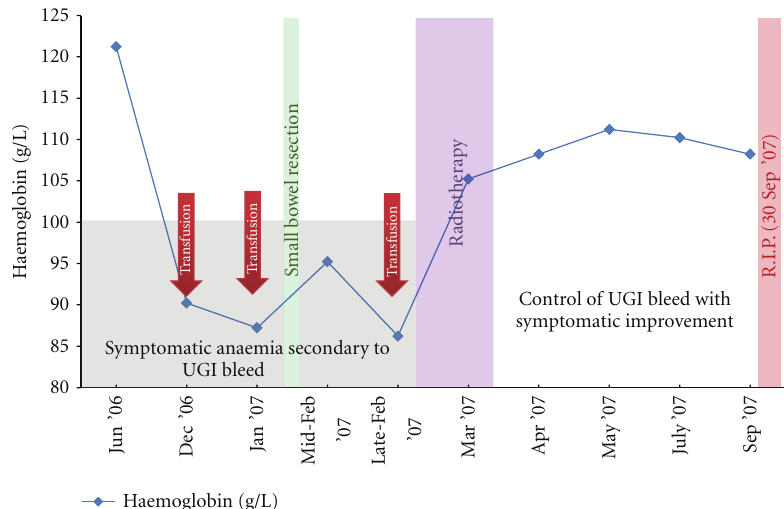
Figure 5: Pre- and postradiotherapy haemoglobin levels of the patient in Case 2. The patient became symptomatic from an occult bleeding caused by a duodenal metastasis of cutaneous melanoma and required continuous transfusion. Palliative radiotherapy of 20 Gy/5 fractions was delivered to control the bleeding. Haemoglobin response to radiotherapy can be appreciated in this graph. (UGI = upper gastrointestinal).